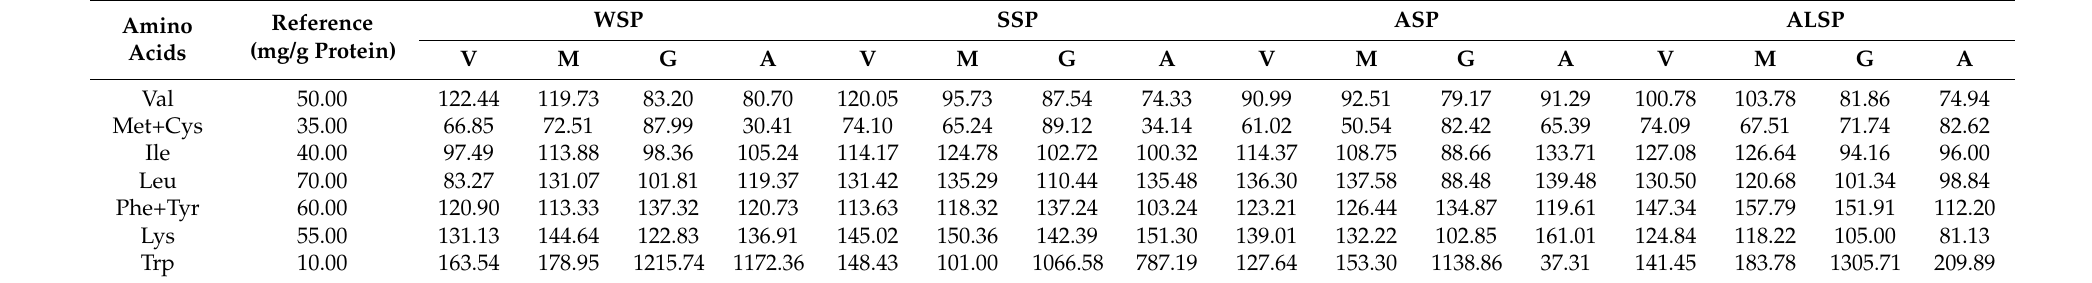
Table 1. Essential amino acid score (EAAS) of proteins in different parts of oyster ( Crassostrea hongkongensis